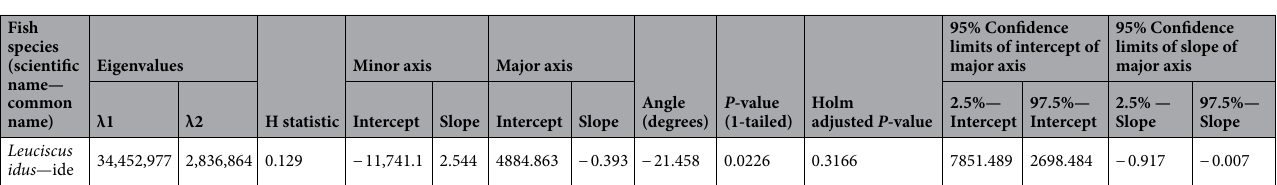
Table 7. Major Axis (MA) model II regression used to assess the dependence of the biomass of Carassius gibelio —Prussian carp on the biomass of Leuciscus idus —ide that were sampled in the recovered course of the Ner River, Poland, over the period of 2000–2012. Untransformed biomass data (in grams) were used. Number of cases (i.e. of sampling surveys) was